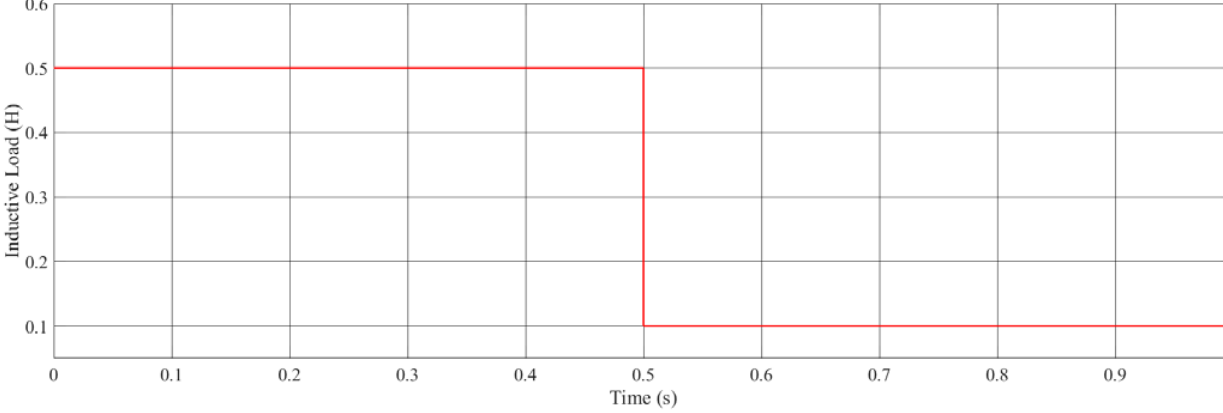
Figure 10. Inductive load variation.